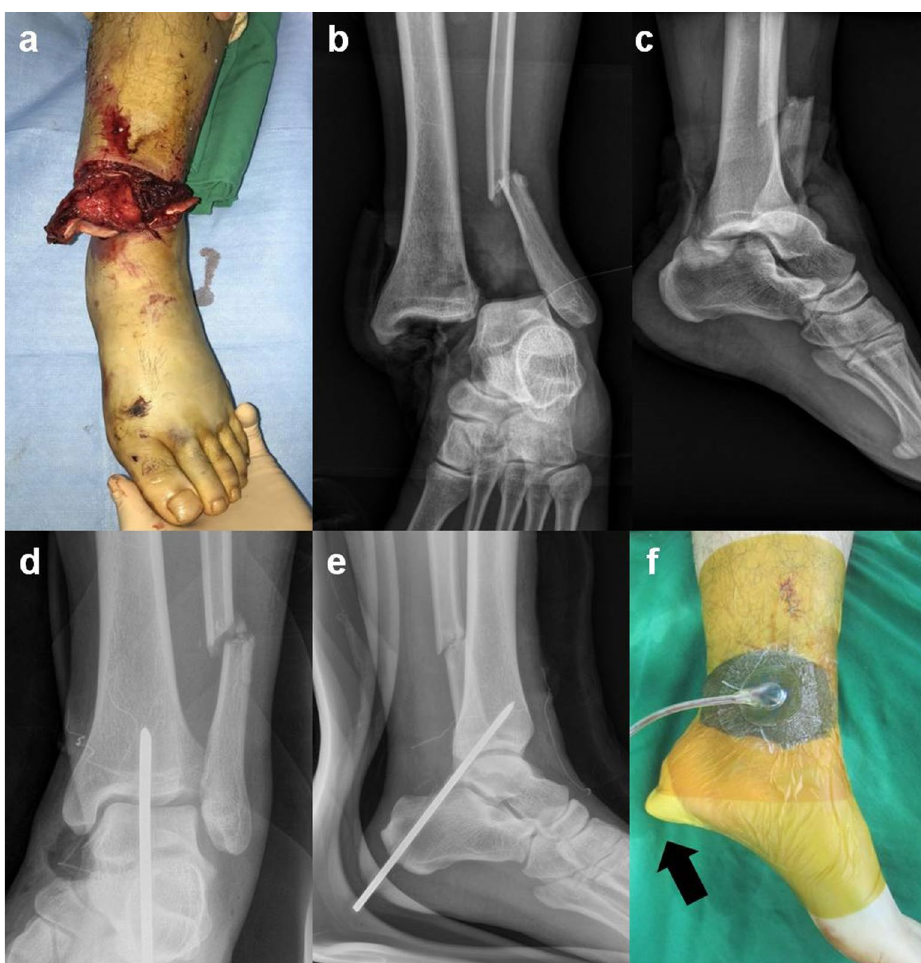
Figure 2. (a,b,c) A 27-year-old male patient presented with ankle dislocation with contaminated soft tissue damage. (d,e) A temporary extra-articular calcaneo-tibial pin fixation stabilized the dislocated or unstable ankle joint after reduction without injuring the articular cartilage of the ankle and the subtalar joints. (f) The wound could be sealed up for negative pressure therapy. The arrow indicates the pin covered with gauze to prevent it from penetrating the